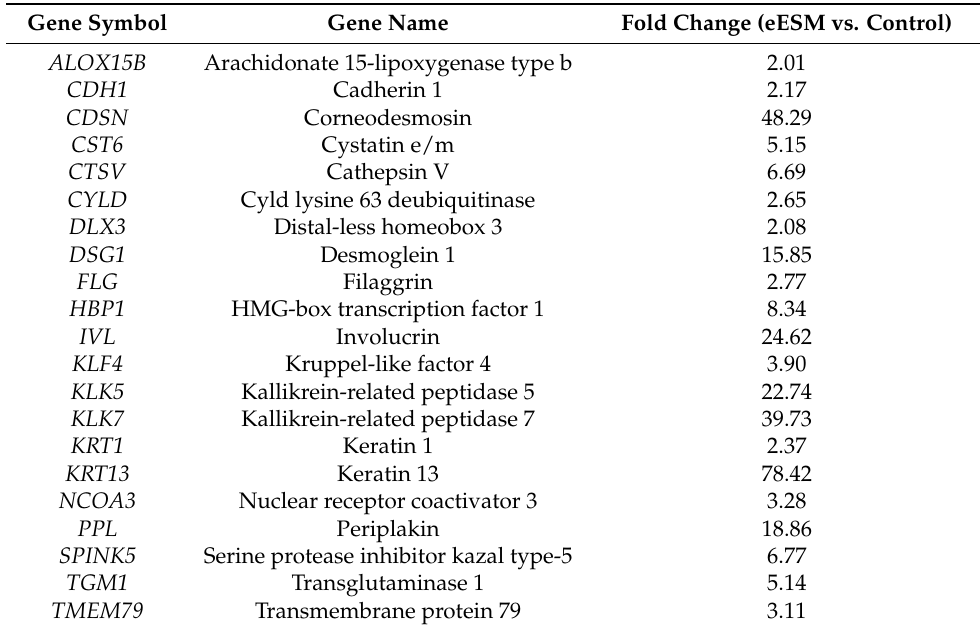
Table 2. List of major genes related to “Formation of